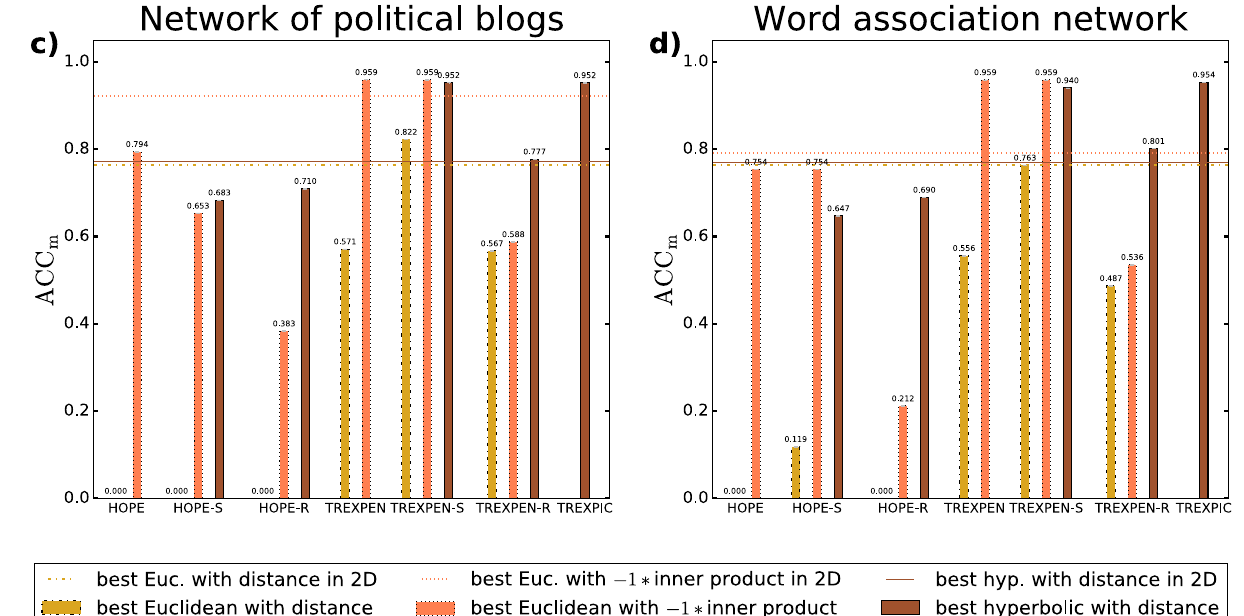
Fig. 5 Mapping accuracy on directed real networks. Each panel refers to a real network named in the title of the panel. For the networks in panels a and b , we measured the mapping accuracy examining each node pair connected by at least one directed path, whereas for the larger networks in panels c and d , the mapping accuracy was measured on fi ve samples of 500,000 node pairs connected by at least one directed path. In the case of the larger networks, we always considered the average of the performances over the fi ve samples and depicted the corresponding standard deviations with (usually very small) grey error bars. The colours indicate the used geometric measure, as listed in the common legend at the bottom of the fi gure. We plotted only the best results in each panel, obtained with the parameter setting that yielded the highest values of the mapping accuracy. Note that the 0 values denote that the given methods have not achieved any positive value. The bars were created considering all the tested number of dimensions, whereas the horizontal lines show the best two-dimensional performances achieved among all the embedding